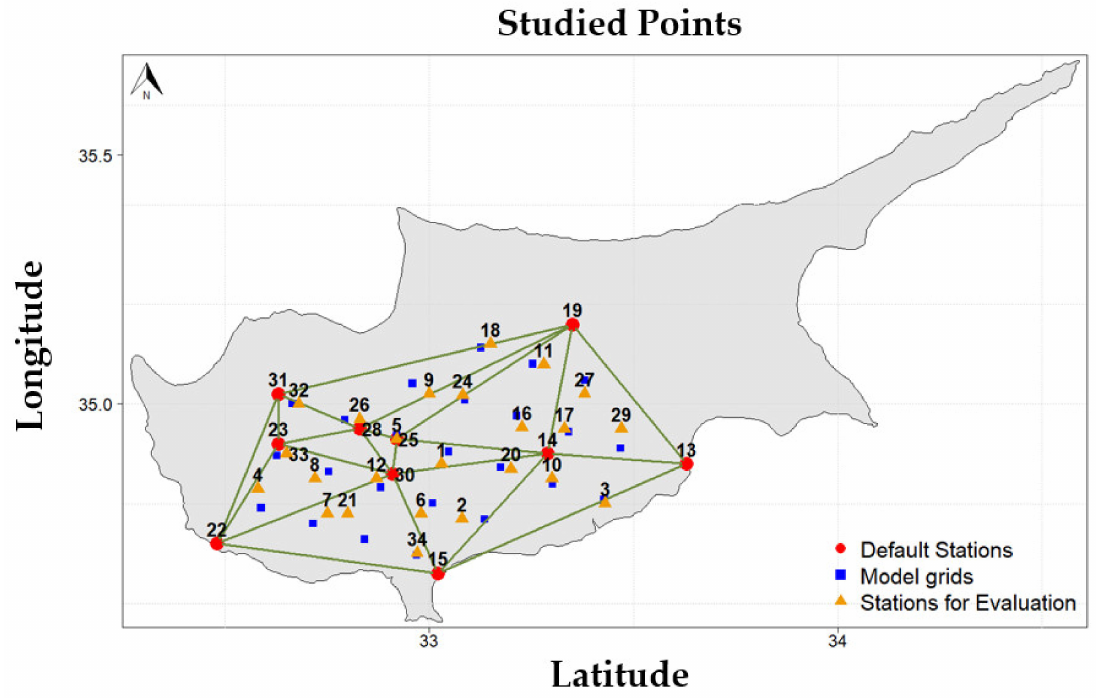
Figure 3. Location of the studied points. Red and yellow points are the available stations. The numbers of these points are in accordance with Table 1. Blue points are the location of the model’s grids. The green triangles present the designed triangular irregular